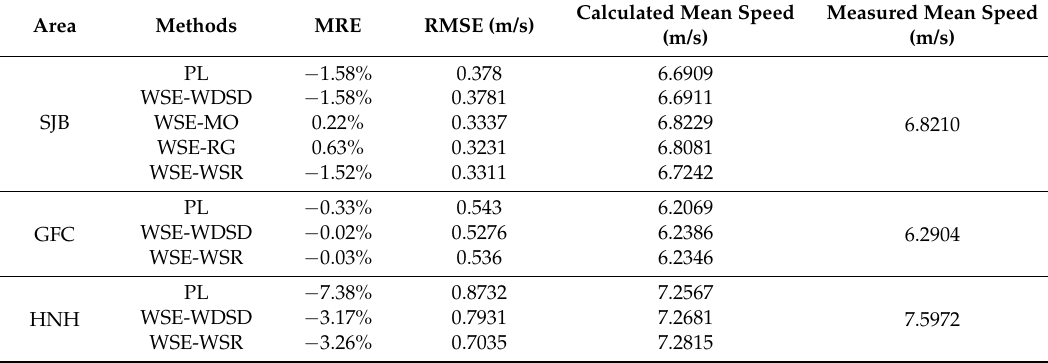
Table 9. Mean wind speed relative error (MRE), root-mean-square error (RMSE) of wind speed and mean speed at the hub height in the three